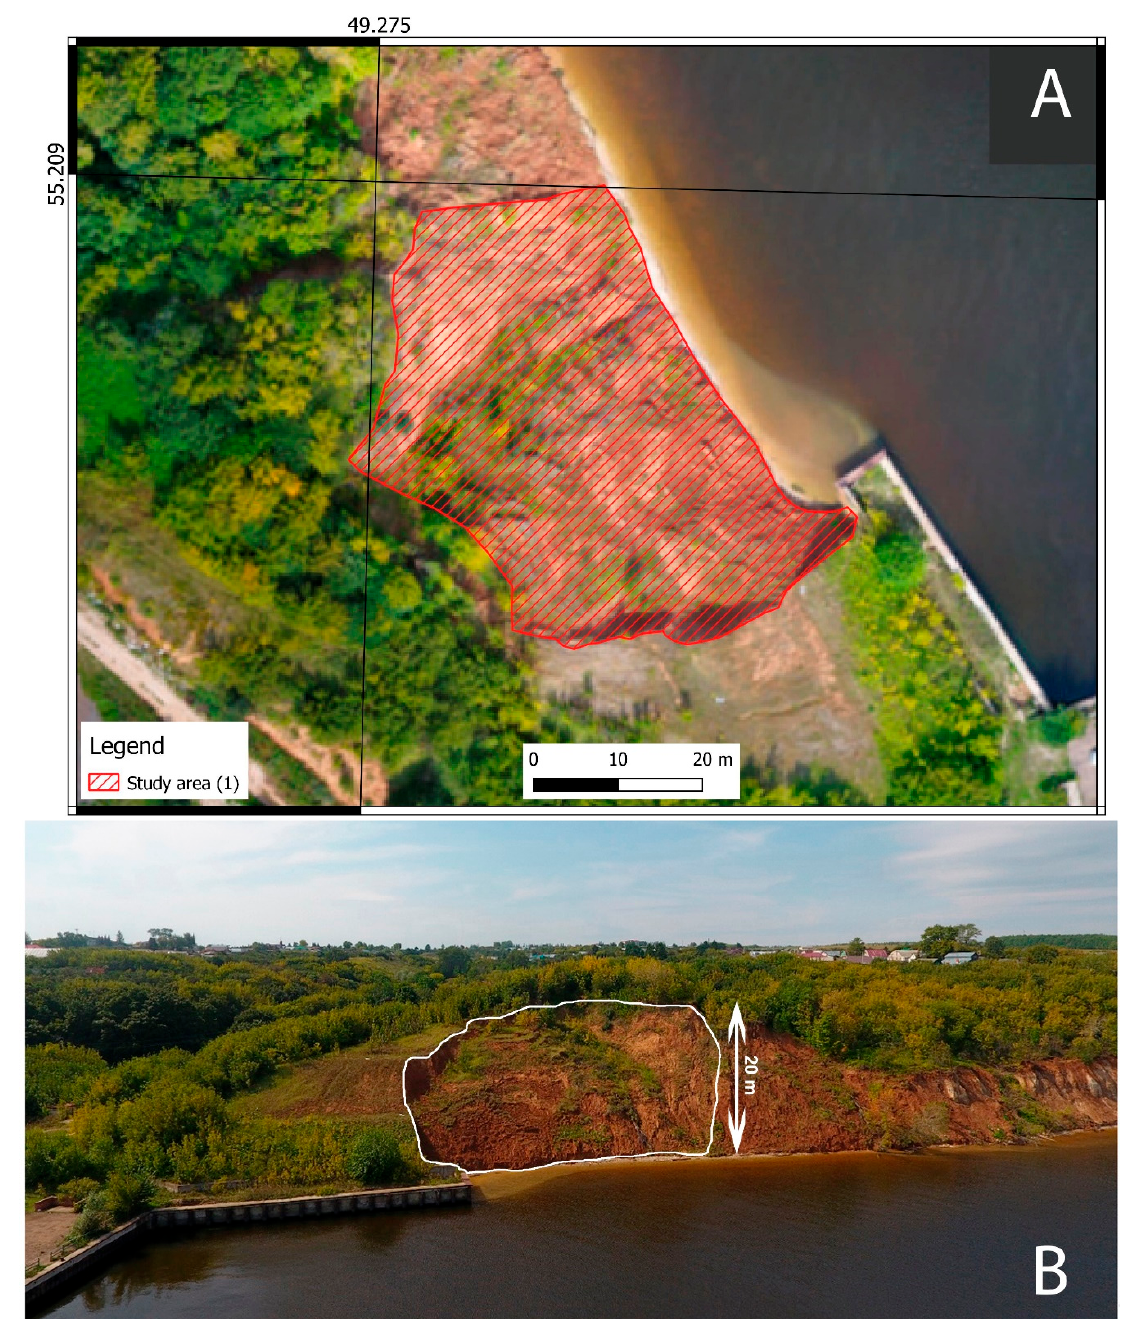
Figure 2. Aerial (2019) ( A ) and oblique views ( B ) of the shoreline and the landslide body at Site 1.